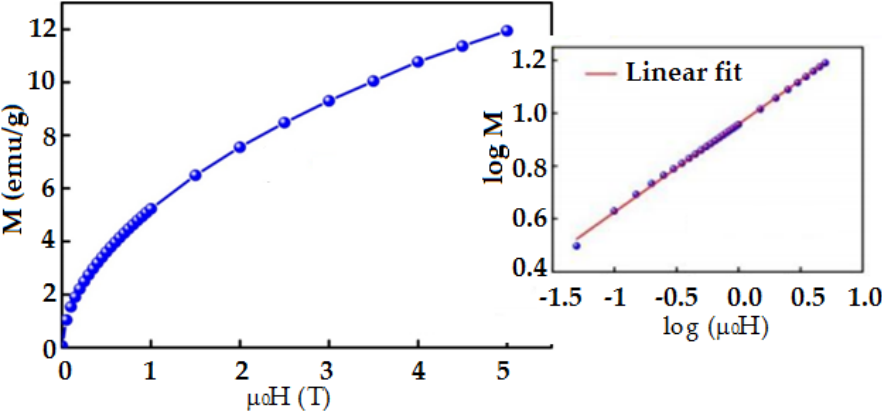
(cid:0) (cid:1) Figure 11. Critical isotherms of 𝑀(𝜇 0 𝐻, 𝑇 𝑐𝐴 ) . The inset shows the logarithmic scale. Figure 11. Critical isotherms of M µ 0 H , T A c . The inset shows the logarithmic Table 2. Comparison of estimated critical exponents of Ni 51.82 Mn 32.37 In 15.81 ribbons with other re- ports and the various theoretical models.